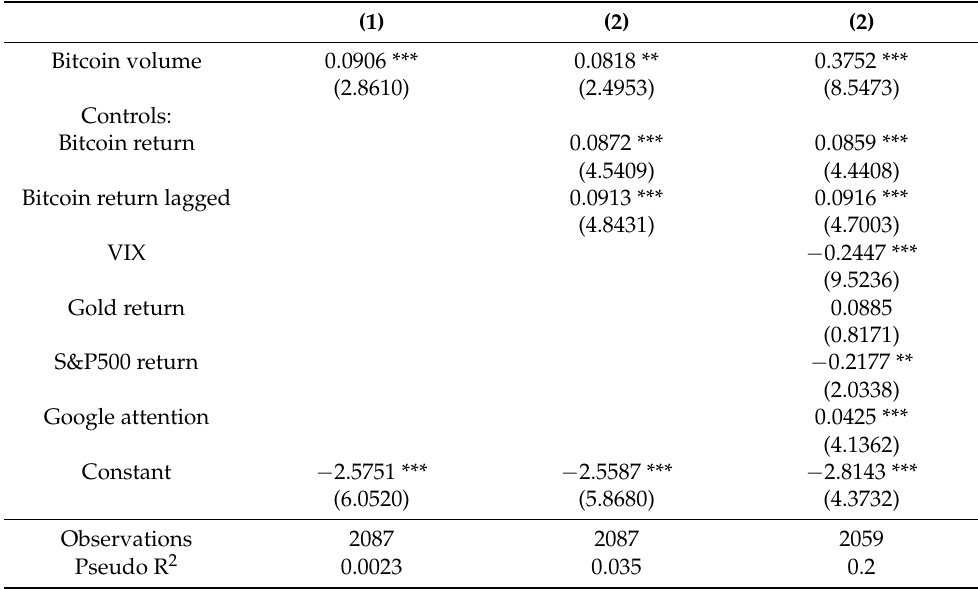
Table A2. The impact of Bitcoin trading volume on the probability of price